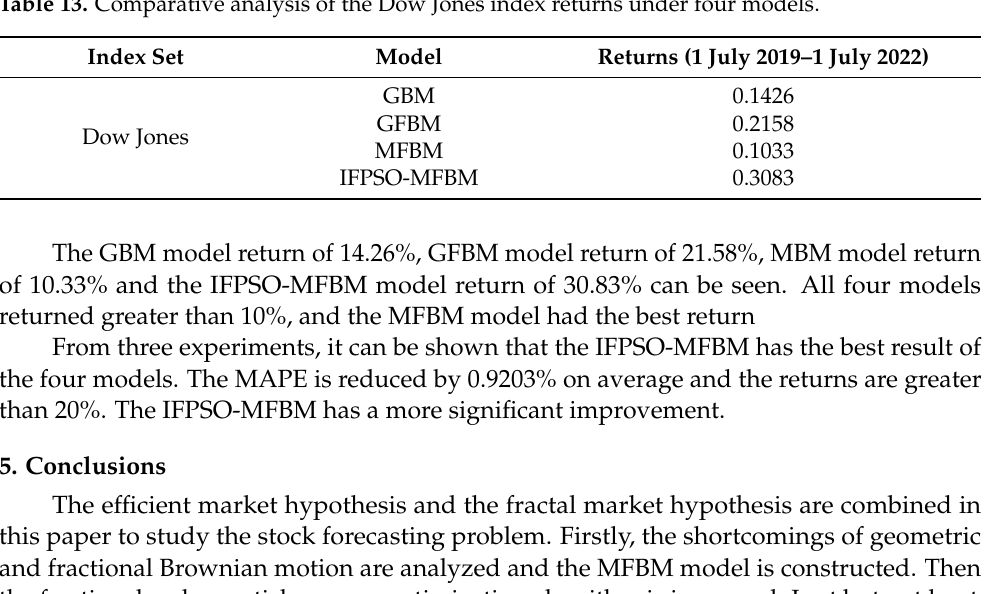
Table 13. Comparative analysis of the Dow Jones index returns under four